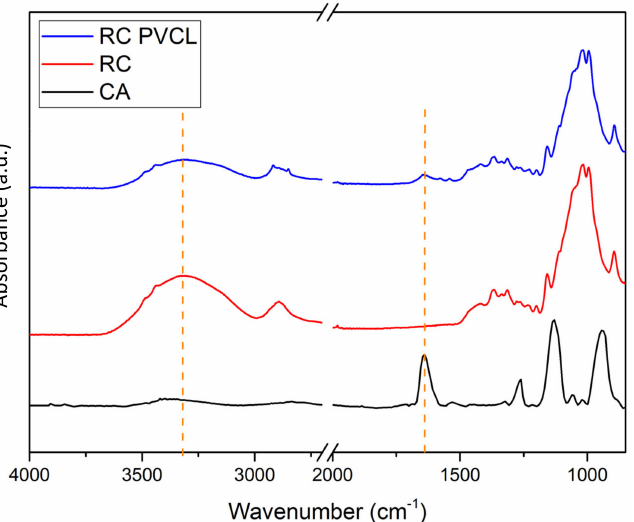
Figure 2. FTIR spectra of the cellulose acetate (CA), regenerated cellulose (RC) and surface–modified RC PVCL membranes.